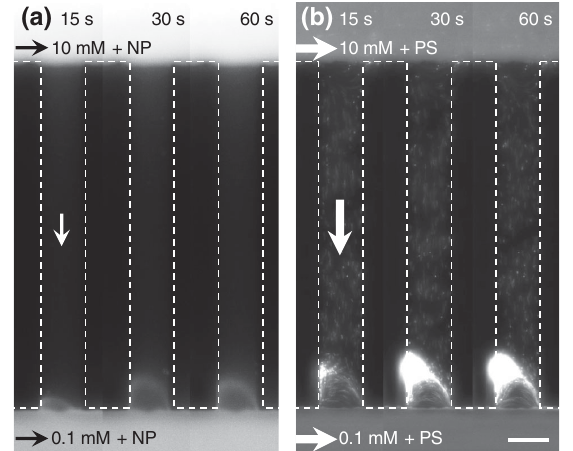
FIG. 2. Flow-induced diffusiophoretic accumulation occurs regardless of the particle size or the flow speed. Image sequences of (a) polystyrene nanoparticles (NP, diameter ¼ 50 nm) focus- ing near the flow junction and (b) polystyrene particles (diameter ¼ 0 . 5 μ m) focusing near the flow junction at a higher pore flow speed u f . In both cases, the solute concentration in the upper stream is c 1 ¼ 10 mM, and the solute concentration in the lower stream is c 2 ¼ 0 . 1 mM. The scale bar is 50 μ m.